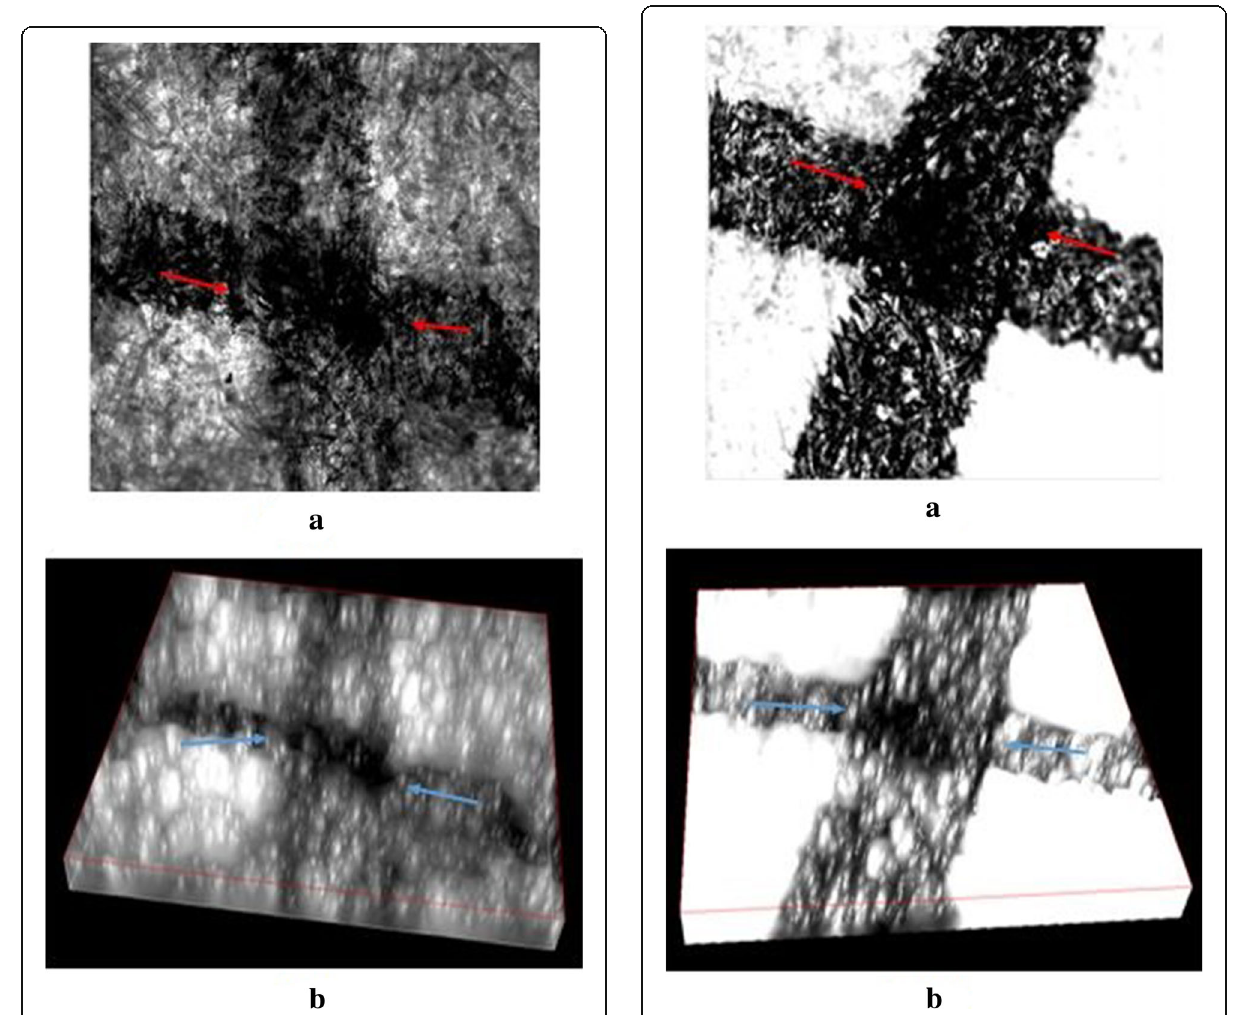
Fig. 10 Cello Pinpoint pen intersecting strokes (medium pen pressure). a 2D figure. b 3D